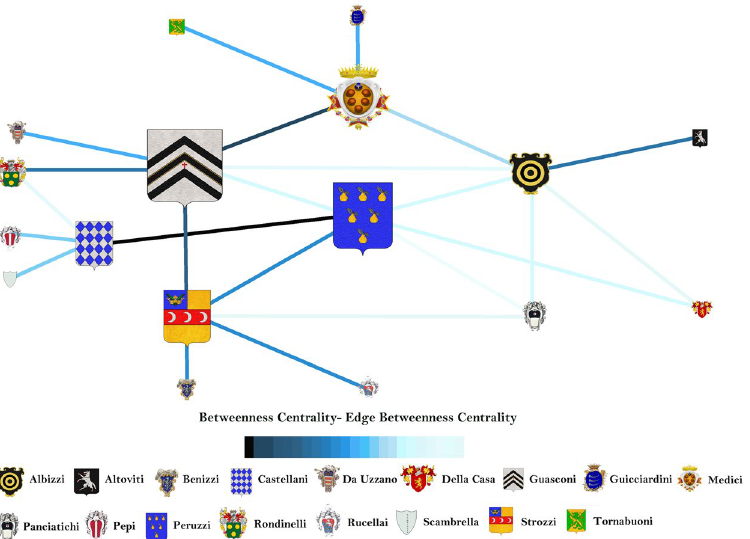
Figure 7. Proposed betweenness centrality, embedding the family intrinsic relevance of the Florence Family network. The intrinsic relevance corresponds to the family gross wealth (in florins) and its value is reported close to the name of each family. Emblem size and edge color (from black for maximum value to cyan for minimum value) highlight the vertex and edge centrality,